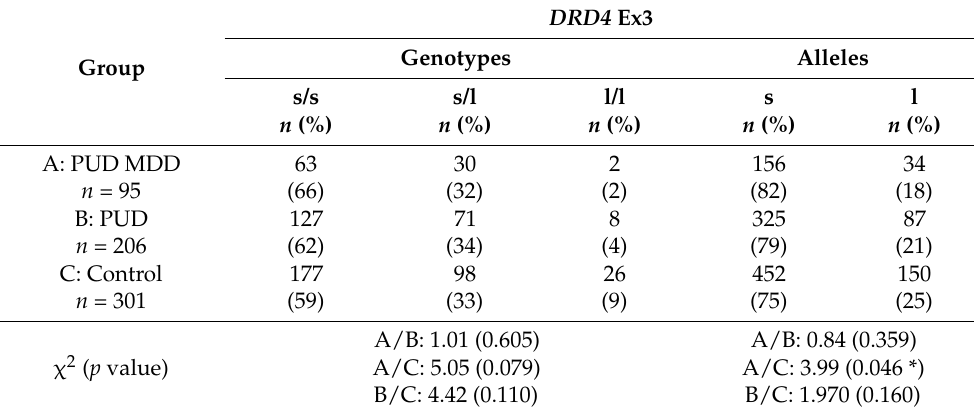
Table 3. Frequency of genotypes of DRD4 exon 3 (Ex3) gene polymorphisms in patients diagnosed with PUD MDD, patients diagnosed with PUD, and control subjects.